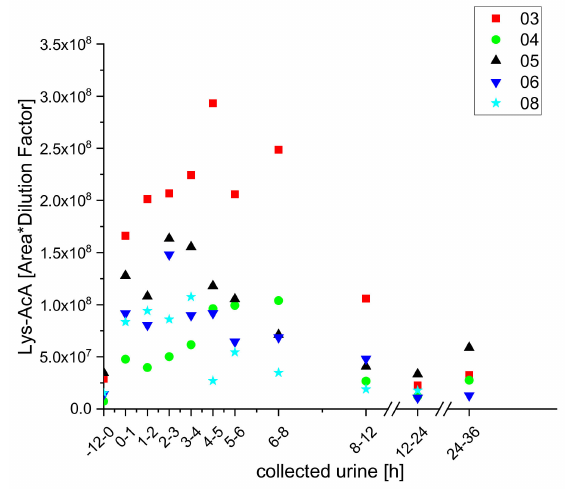
Figure 11. Excretion kinetics of Lys-AcA: UPLC-qToF-MS / MS measurements of contents in samples of urine from participants three, four, five, six, and eight at indicated times after co ff ee consumption